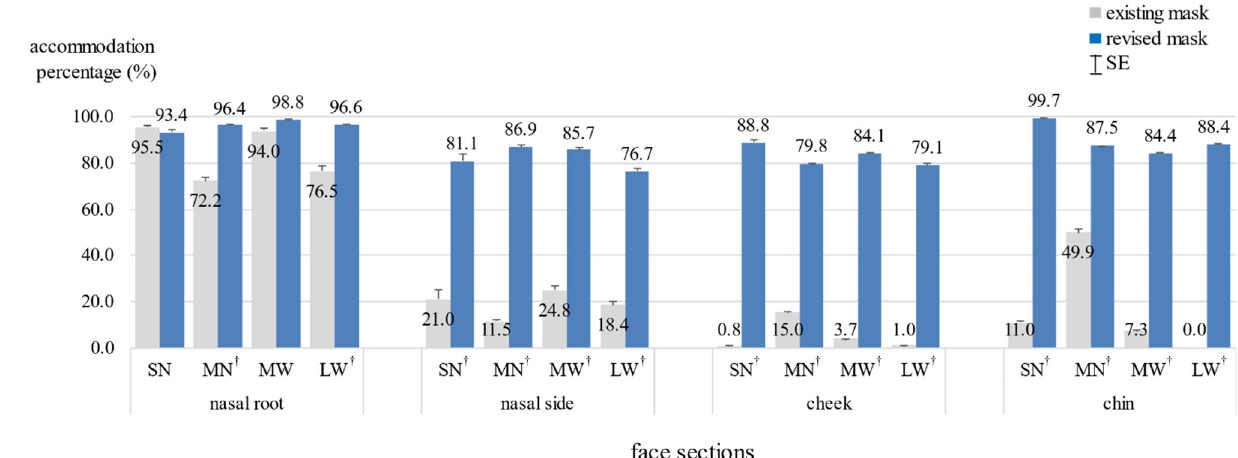
Figure 10. Comparison of the accommodation percentages of the existing and revised oxygen mask designs by mask size category (SN: small narrow, MN: medium narrow, MW: medium wide, and LW: large wide; † significant at α = 0.05).